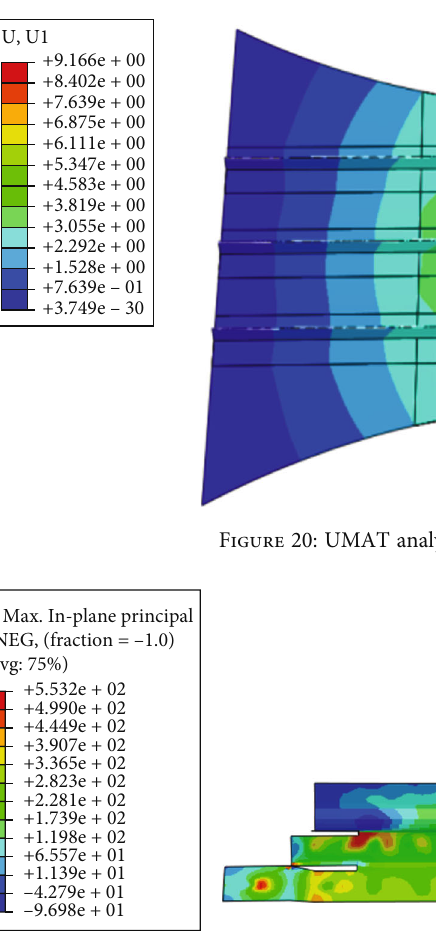
Figure 21: UMAT analysis maximum in-plain principal stress in the upper repair panel (MPa). S, Max. In-plane principal SNEG, (fraction = –1.0)